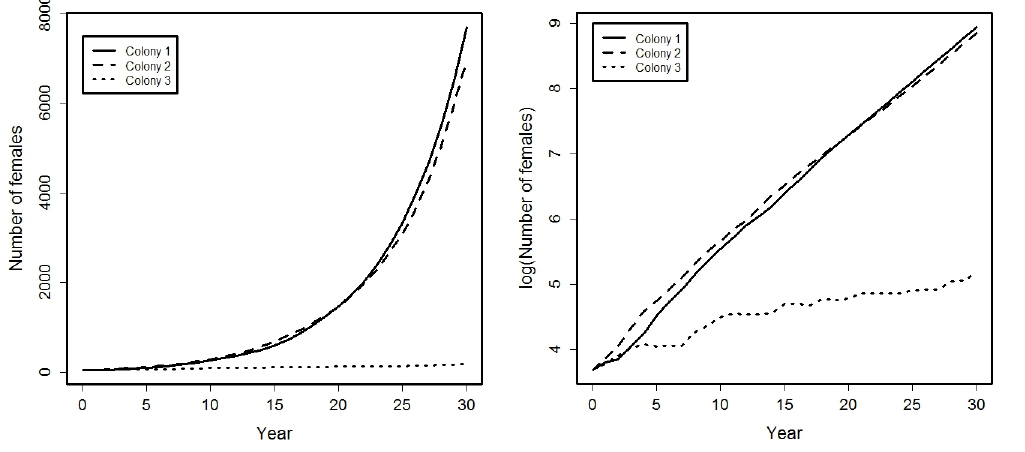
Figure 1. Evolution, during a period of 30 years, of the total number of females in each colony ( left graphic ) and its corresponding logarithms ( right graphic ).